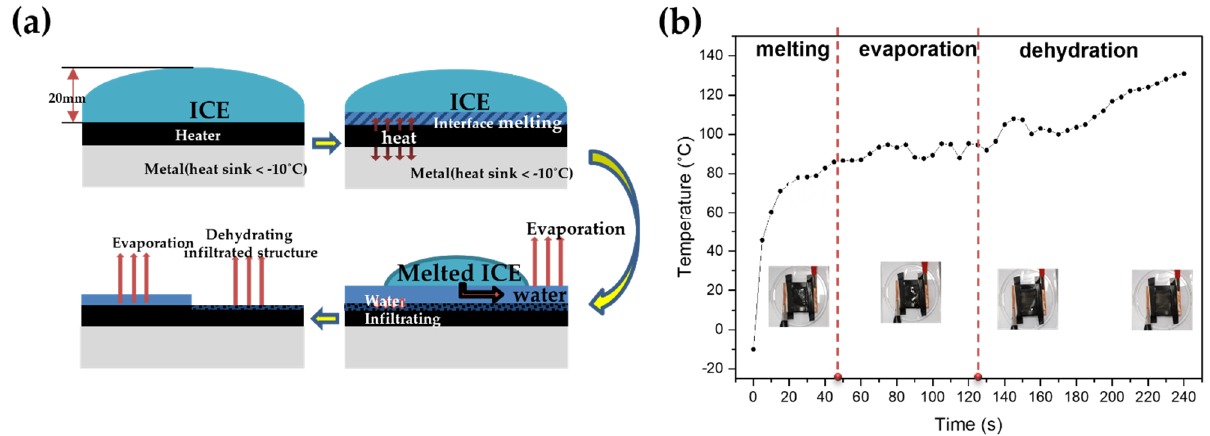
Figure 7. ( a ) Illustration of the deicing process based on electrothermal effect, ( b ) temperature graph of deicing with Cu/LIG heater.